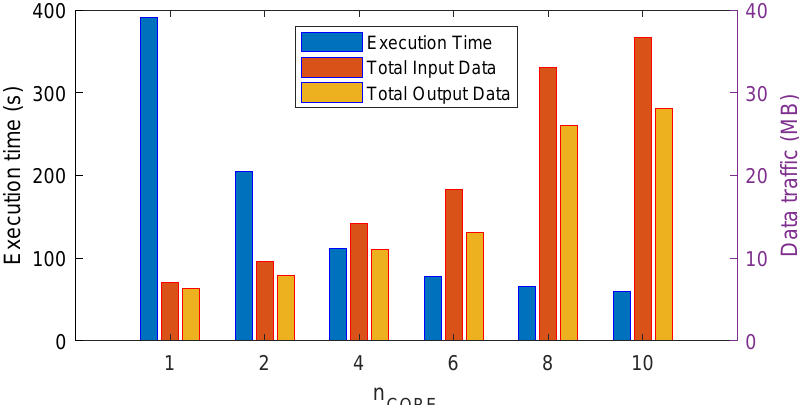
Figure 13. Bar-plots profiling the simulation times and corresponding input/output data traffics generated by parallel executions of GeneticTA_par for increasing values of the number n core of the employed cores under DAG1 at PS = 300. The case: n core = 1 corresponds to the sequential execution of GeneticTA_par .